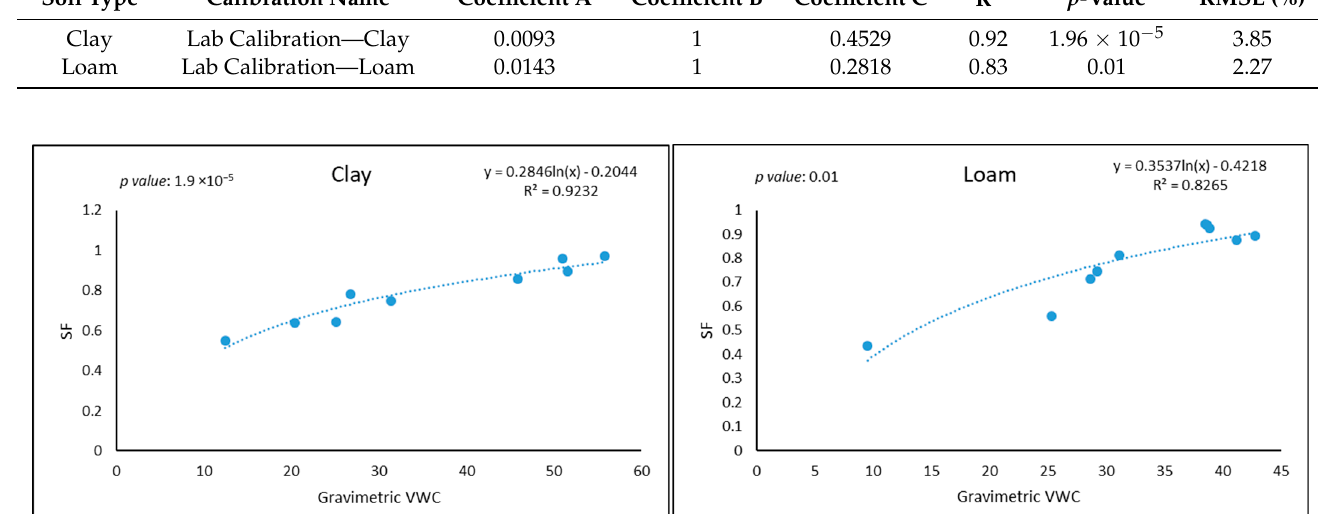
Figure 10. Clay and Loam Gravimetric VWC compared with derived VWC. Table 9. Statistical metrics associated with coefficients of various calibration equations (Laboratory calibration—Phase 1). Soil Type